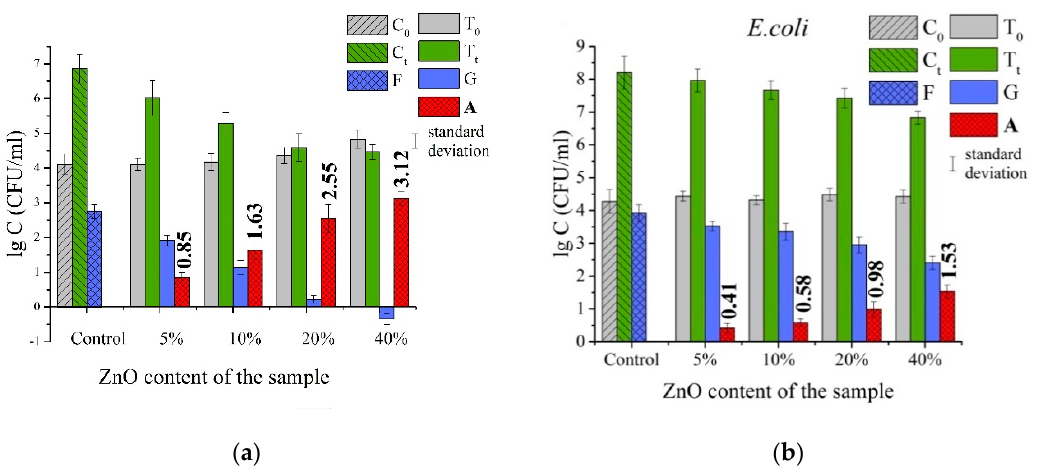
Figure 6. Results of antibacterial tests according to the ISO 20743:2013 standard obtained for S. aureus ( a ) and E. coli ( b ) bacteria.